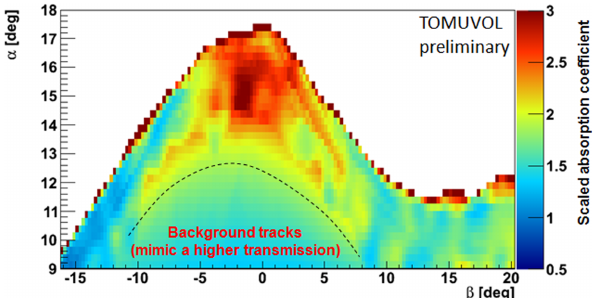
Fig. 3. Map of the scaled transmission through the Puy de Dˆome as seen over seven months from the Grotte de la Taillerie with a ∼ 1/6m 2